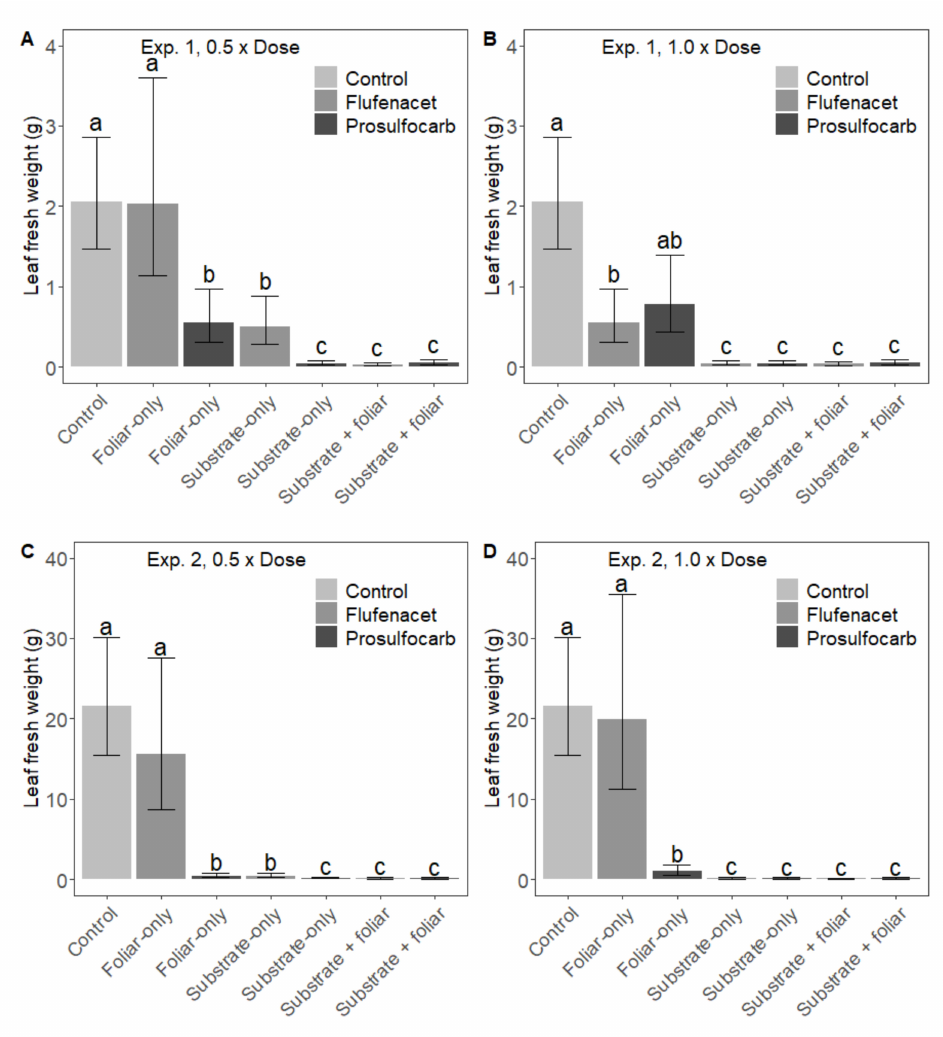
Figure 2. Estimated mean values of the foliar fresh weights (g) (with error bars representing 95% confidence intervals) after spraying with half (0.5 × dose) and recommended dose (1.0 × dose)